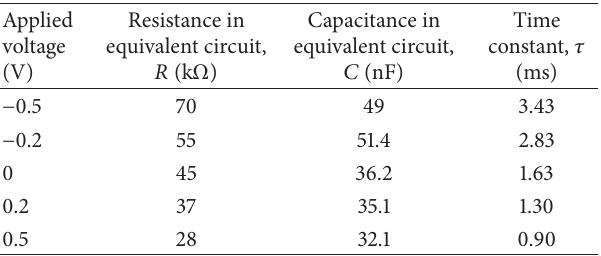
Table 3: The value of 𝑅 , 𝐶 , and corresponding 𝜏 obtained from the measured impedance spectra under different bias voltage con- ditions.